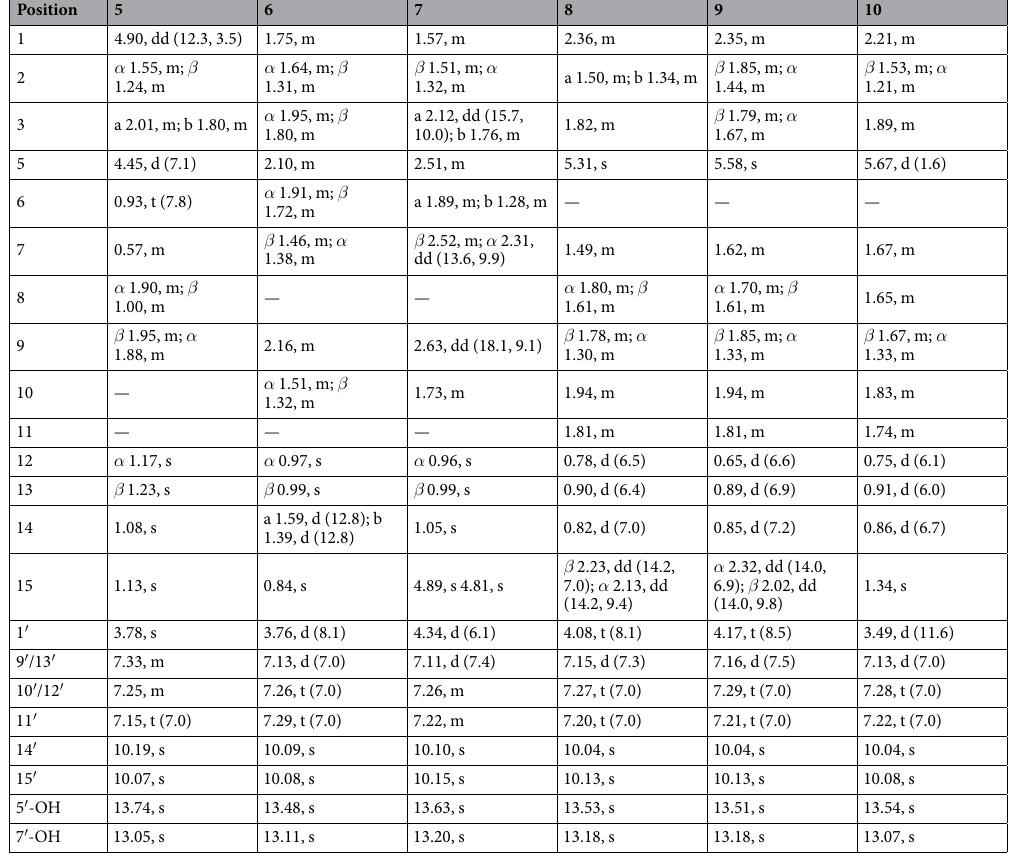
Table 3. 1 H NMR (400 Hz) data of compounds 5 – 10 in CDCl 3 ( δ in ppm, J in